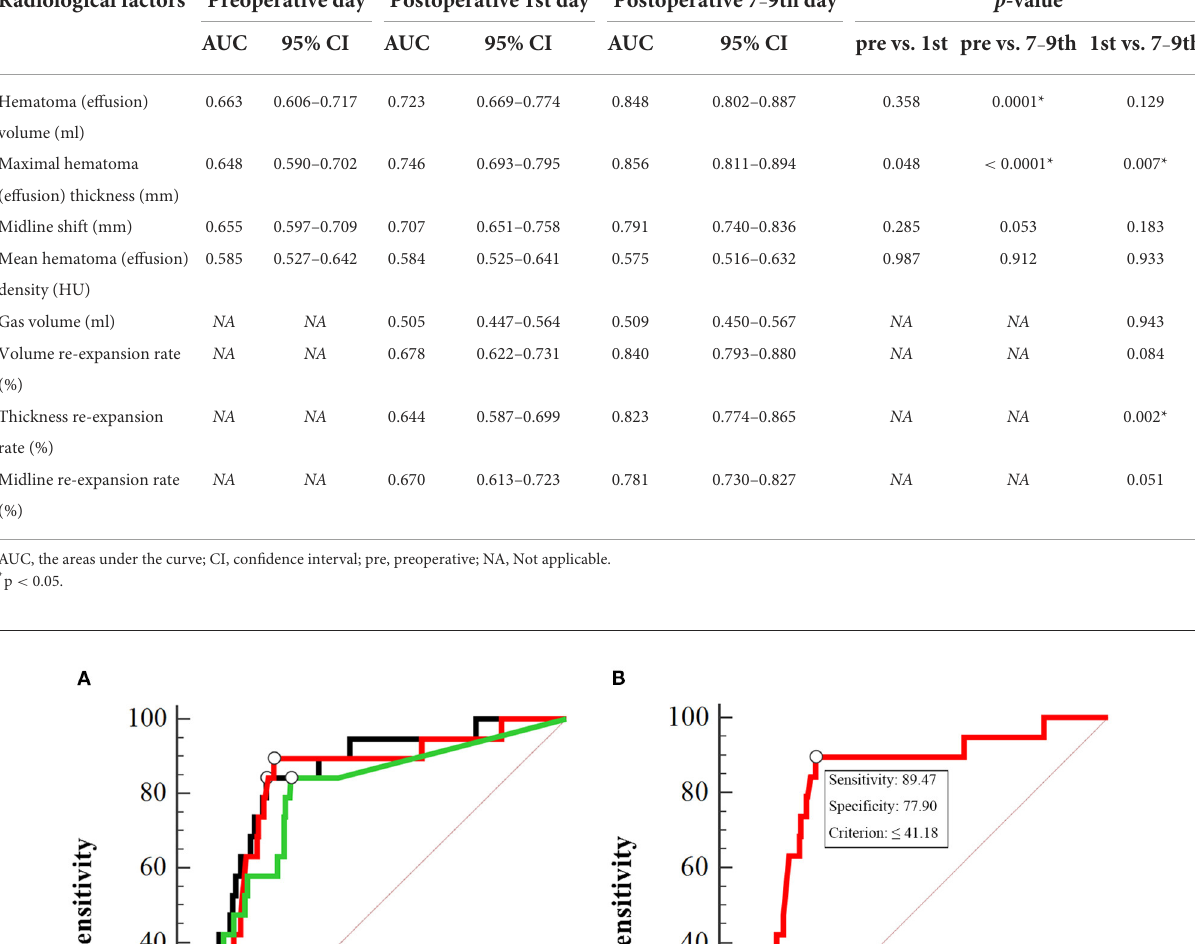
TABLE 3 Comparison of radiological characteristics at different times ( n = 295).